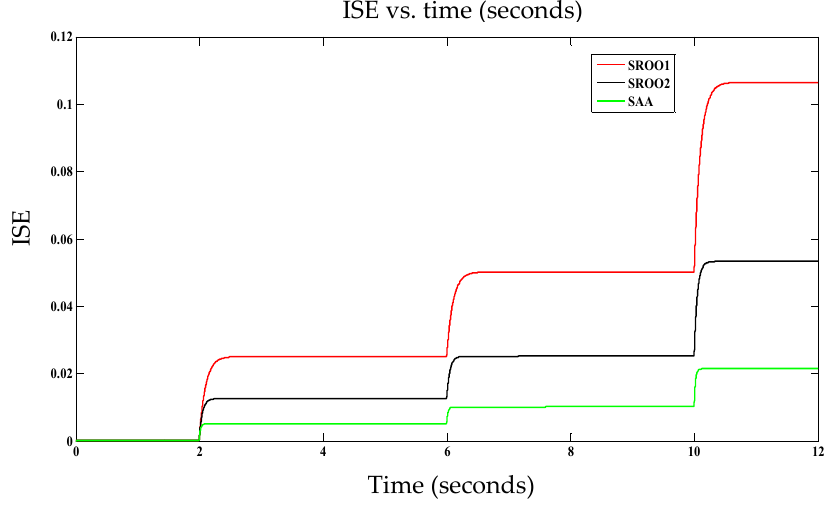
Figure 12. Integral square error (ISE) vs. time—Luo converter-fed DC motor.